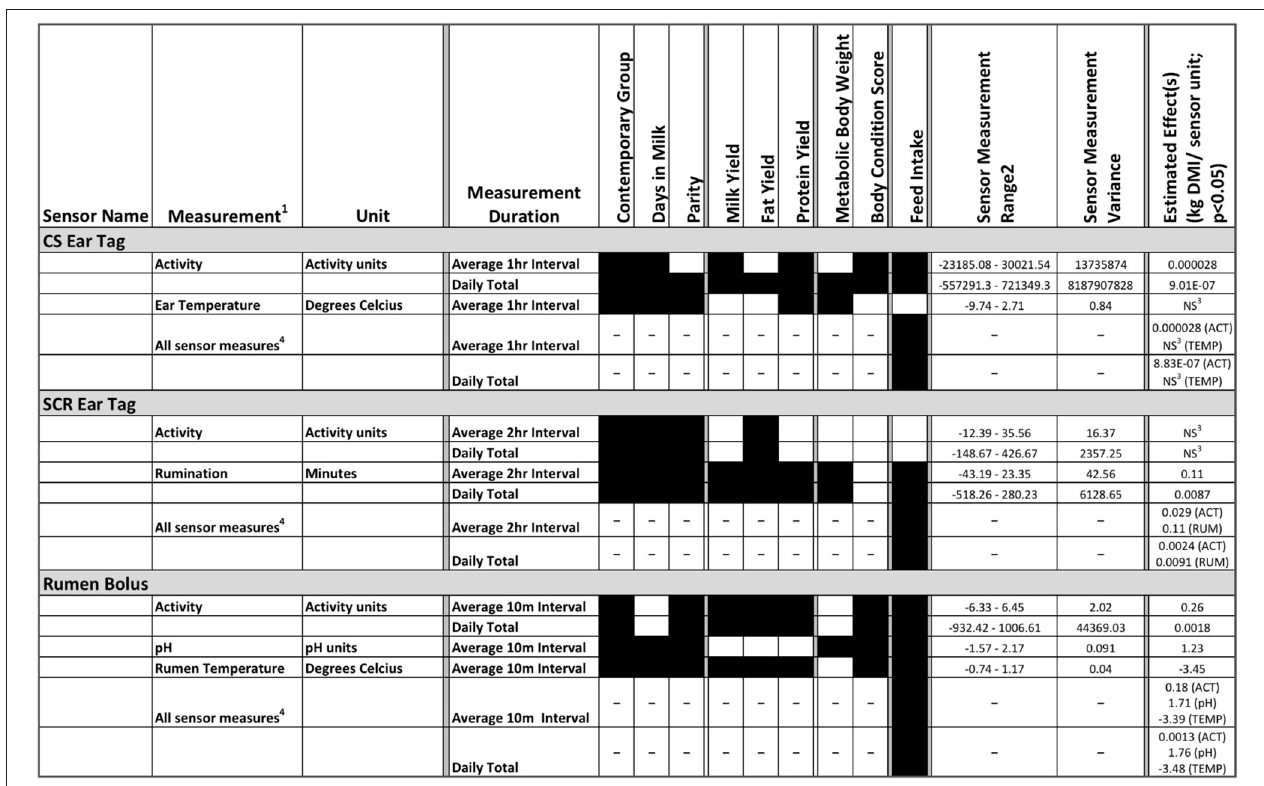
FIGURE 1 | A graphical summary of all statistically significant sensor measure associations with management and physiological factors (contemporary group, days in milk, parity), production traits (milk, fat and protein yield), body weight and body condition score (BCS) and feed intake (dry mater intake; DMI) traits. Three wearable sensor types including: CowSense (CS) ear tag, SCR ear tag, and rumen bolus, were used to collect 2, 2, and 3 individual measurements, respectively. Black filled boxes indicate significant associations ( p < 0.05) with the trait listed in the column for an individual sensor measurement type at one of two measurement intervals. The two measurement intervals per individual sensor measurement are: 1) the average for a sensor’s predefined measurement interval across an entire day, and 2) the daily total sum across all measurement intervals. For each wearable sensor, all individual measurements within that wearable sensor were also combined into a single model to determine the statistical association with feed efficiency traits (labeled as all sensor measures). 1 The number of records per sensor measurement are found in Table 1 . 2 Range of sensor measurements adjusted for parity, contemporary group, and days in milk. 3 NS = Not significant ( P > 0.05). 4 Associations with traits other than feed intake not applicable for the all sensor measures